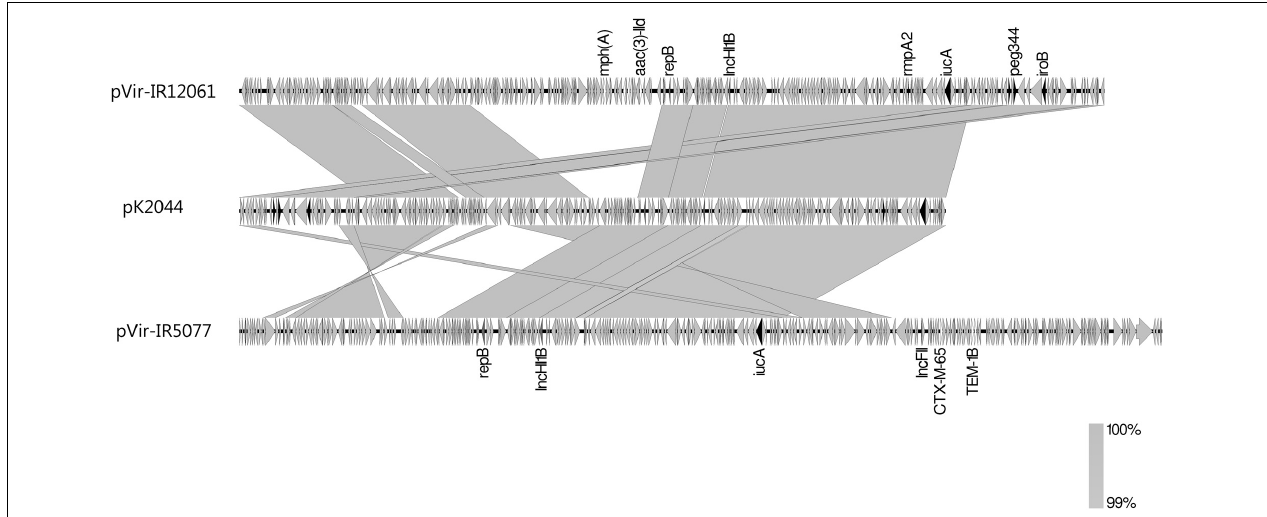
FIGURE 5 | Linear comparison of virulence plasmids pVir-IR12061_1, pVir-IR5077_3, and pK2044. Virulence genes are shown by dark arrows. Other genes are denoted by gray arrows. Regions of synteny between adjacent schematics are indicated by the gray-shaded areas.